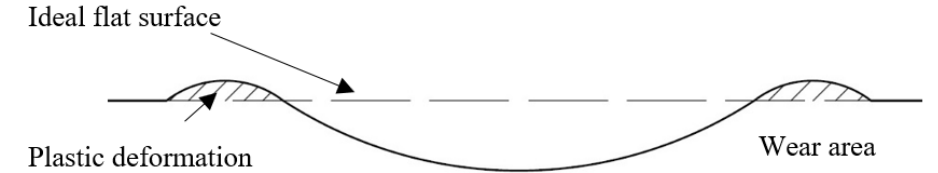
Figure 6. Marked area of removed and printed